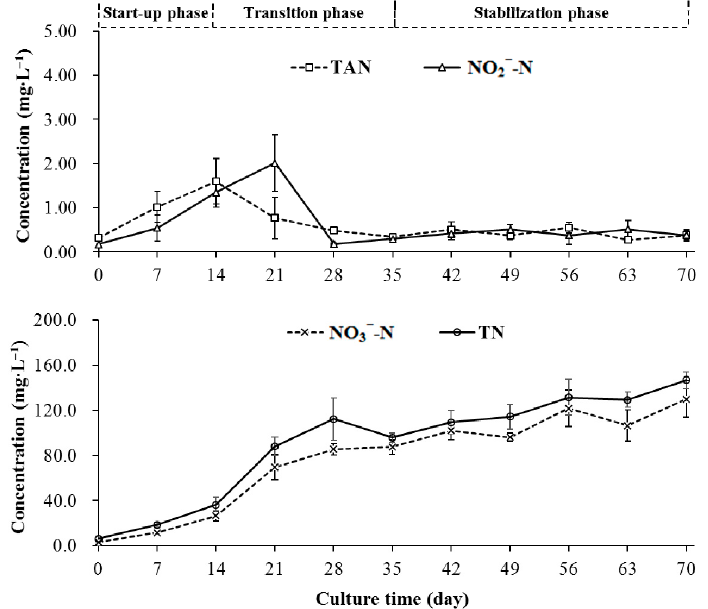
Figure 3. Concentration variation of TAN, NO 2 − -N, NO 3 − -N, and TN in shrimp culture tanks of the biofloc-RAS during a 70-day production trial (mean ± S.D., N = 3).